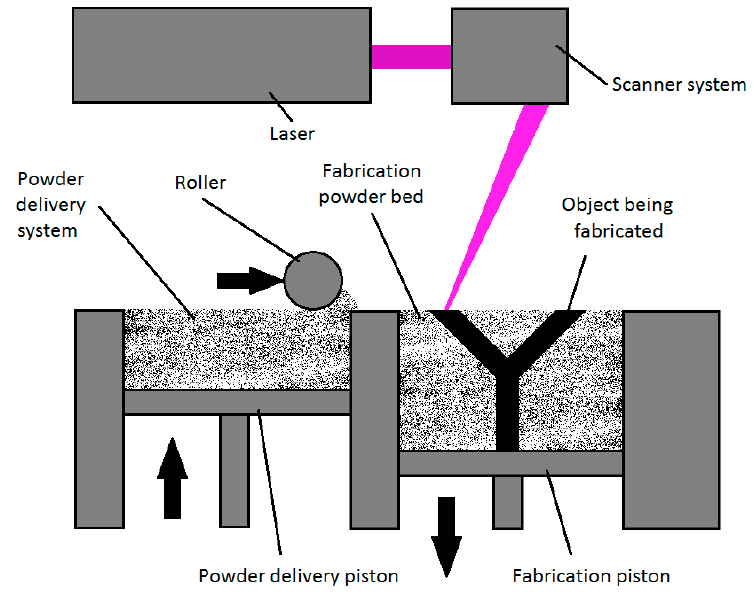
Figure 1. The principle of the selective laser melting (SLM) process.